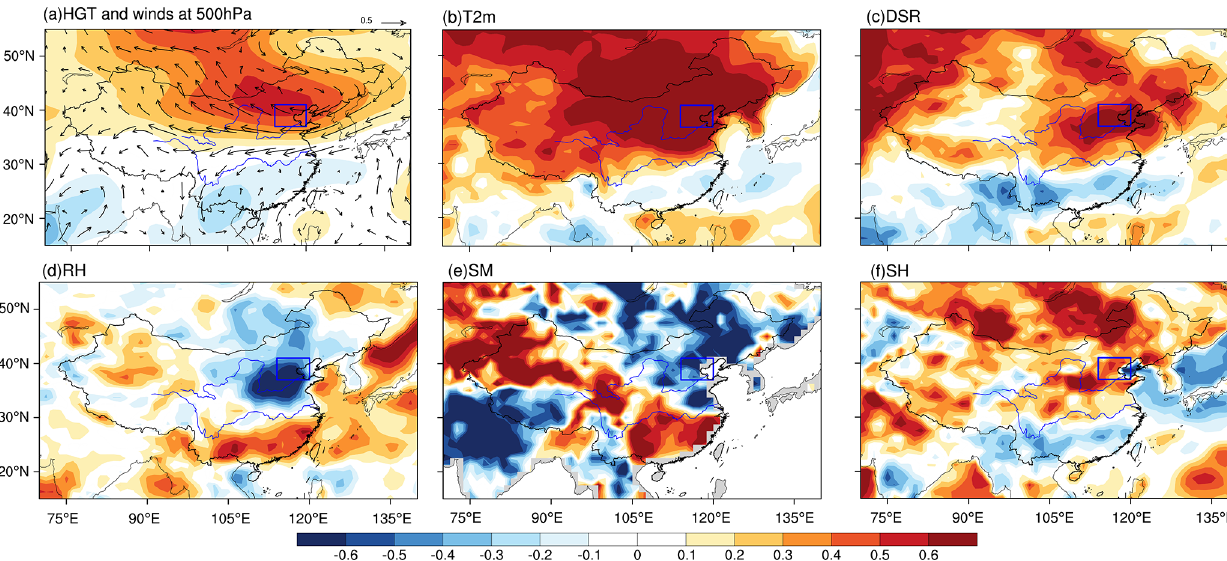
Figure 4. Composites of normalized anomalous (a) geopotential height (HGT) and winds at 500hPa, (b) 2m air temperature (T2m), (c) downward solar radiation flux (DSR), (d) relative humidity (RH), (e) soil moisture content (SM), and (f) sensible heat flux (SH) at the surface during coupled extremes (OPCs). The blue box in each panel indicates the NCP region.